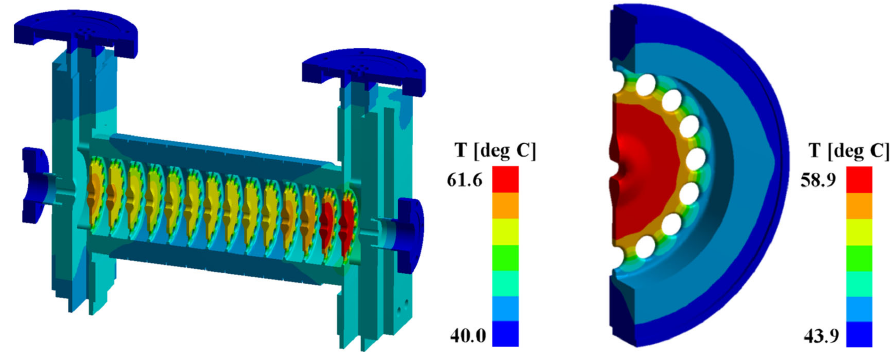
FIG. 17. Temperature map of the full structure (left) and cell #12 (right) in the steady-state